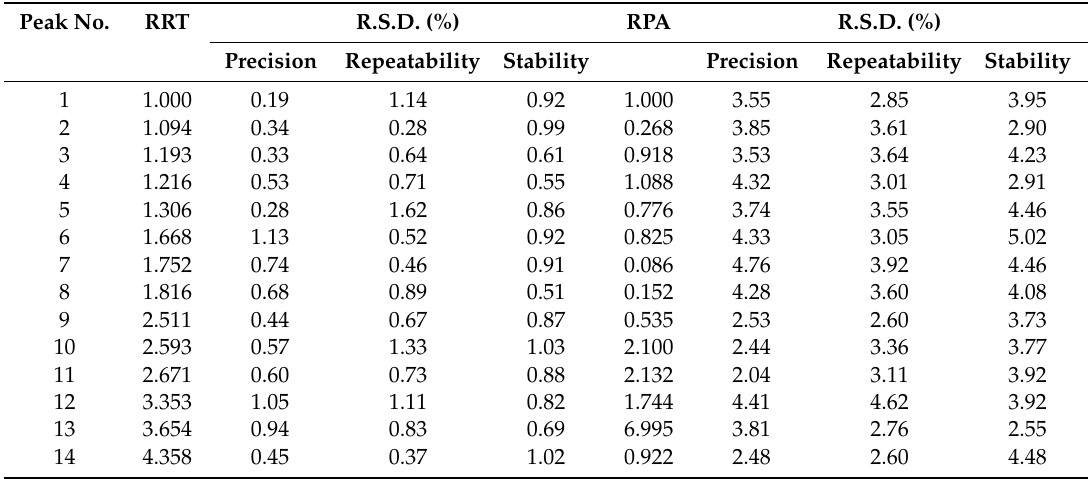
Table2. Resultsofrelativeretentiontimesandrelativepeakareasofprecision, repeatability, andstability. Peak No.